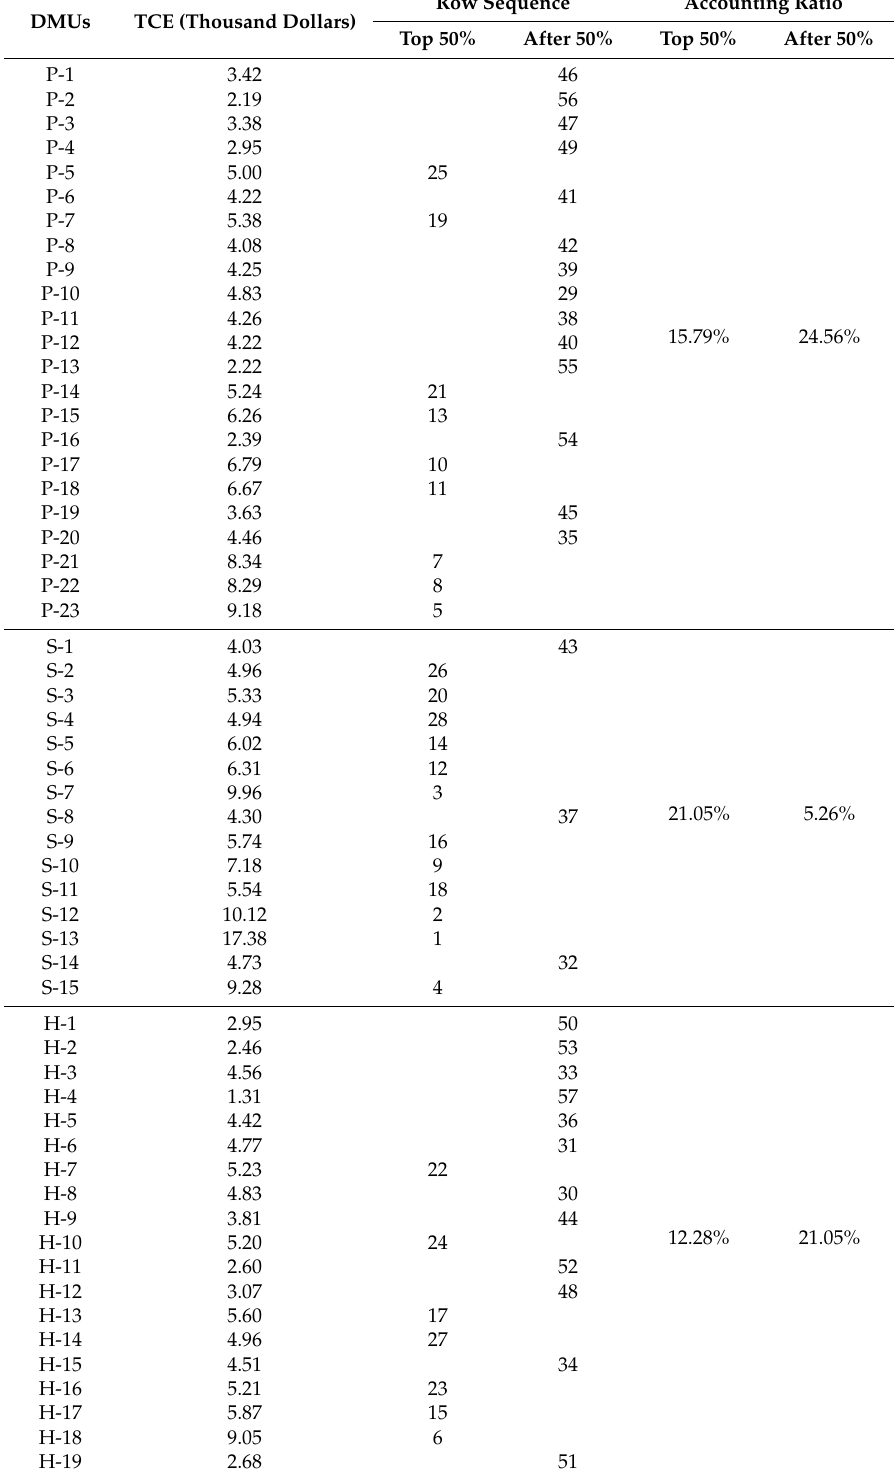
Table A2. Ship row sequence and accounting ratio of time charter equivalent (TCE) for bulk shipping